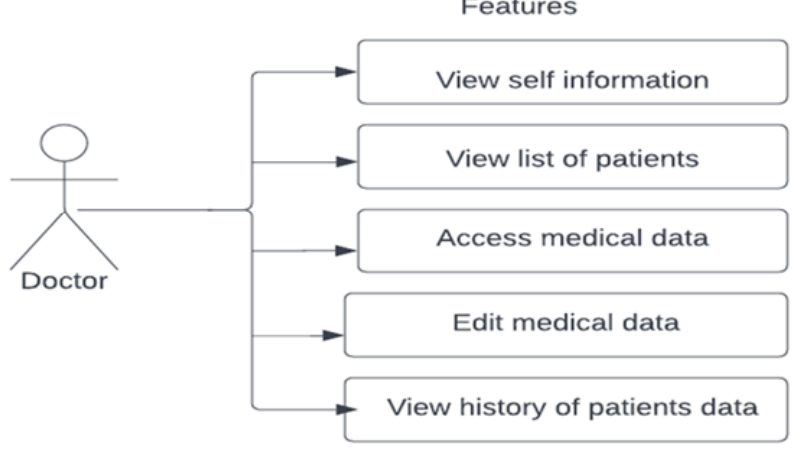
Figure 6. Illustration of the doctor persona.